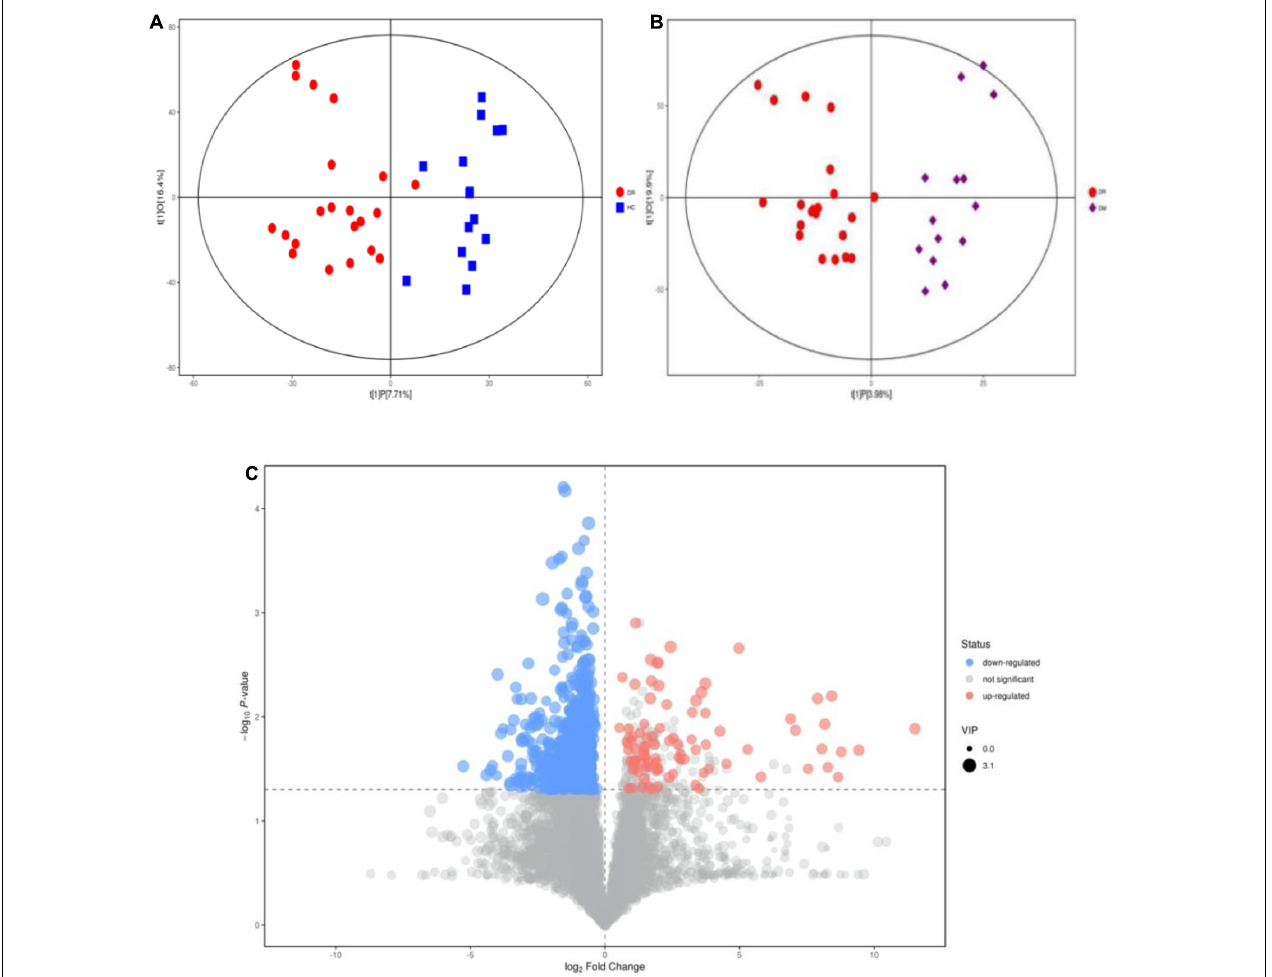
FIGURE 3 | Alteration of metabolites Changes between DR patients and healthy people and between DR patients and DM patients. (A) OPLS-DA score samples of fecal samples from DR patients (red circle) and healthy controls (blue square). (B) OPLS-DA of fecal samples from DR patients (blue circle) and DM patients (purple square). (C) The variation tendencies of fecal metabolites between DR patients and healthy people. The red circles indicate the up-regulated metabolites and blue circles indicate the down-regulated